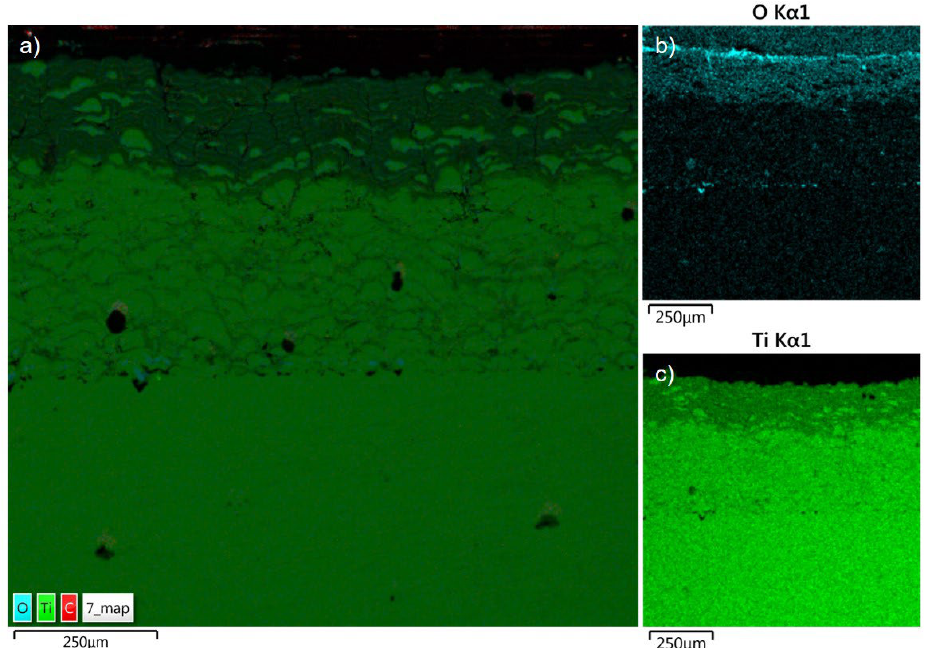
Figure 7. EDS analysis by light of the cross section of the coating having a gradient structure: ( a ) microphotograph, ( b ) O, and ( c ) Ti.